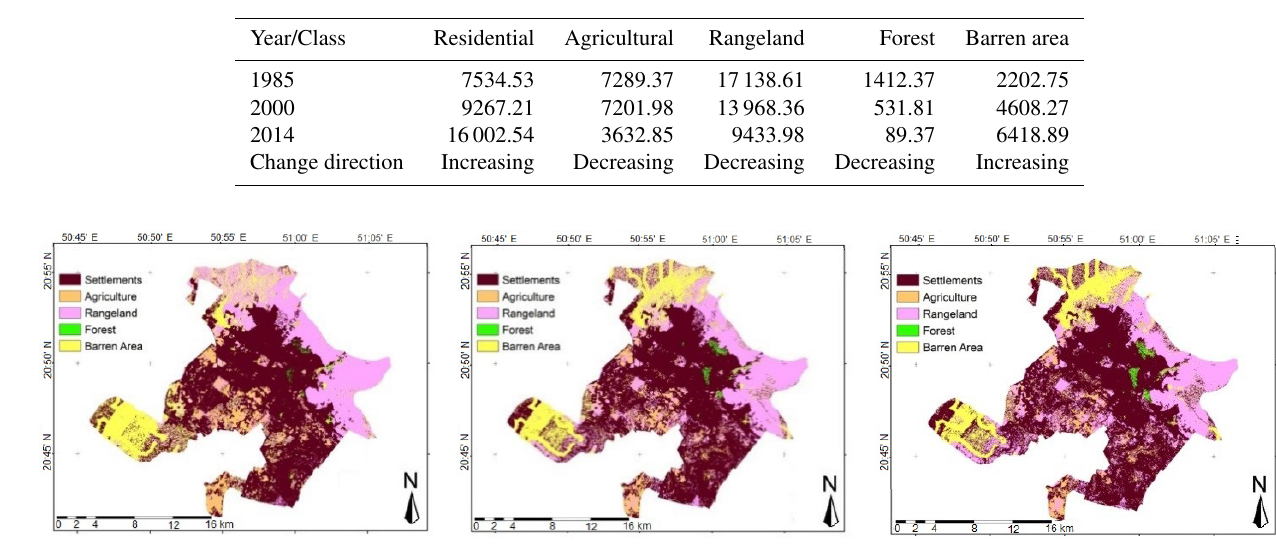
Figure 4. Predicted land use/cover classes in different